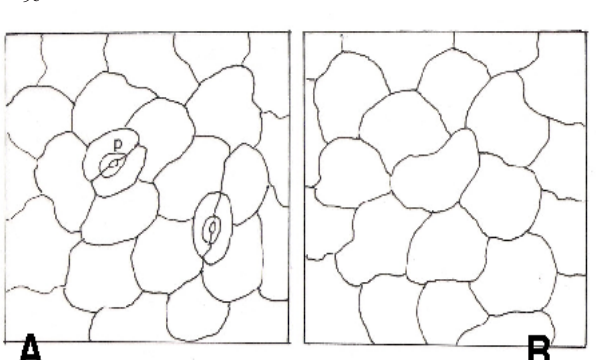
Fig. 3. Surface view of leaf epidermis, abaxial (A) and adaxial (B) of Euphorbia milii Propagated with 1.25cc daily watering regime showing paracytic (p) stomata Tab. 4. Stomatal anatomy of Agave americana raised with